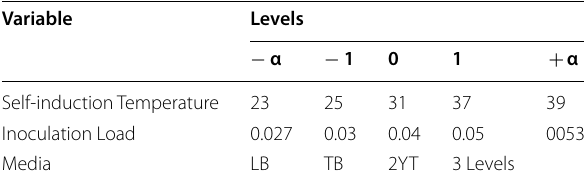
Table 2 The variables and their levels used in central composite